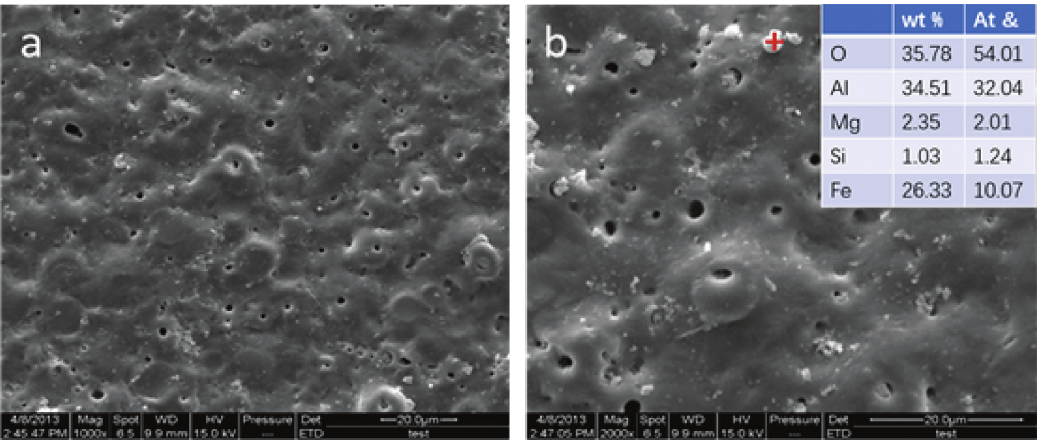
Figure 3: Surface morphologies of the MAO